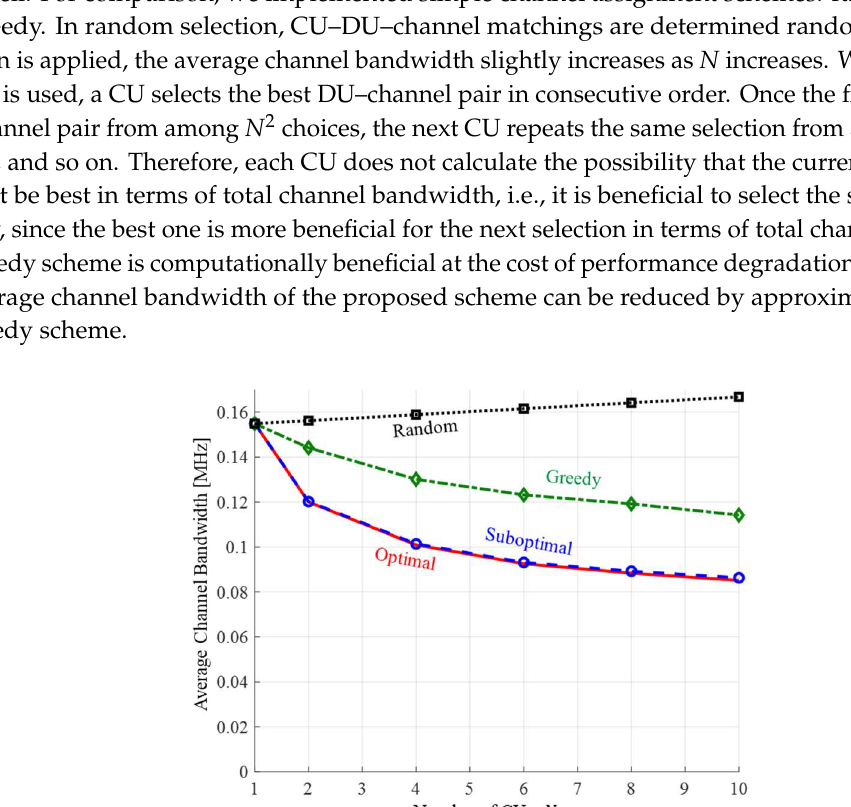
Figure 4. Snapshot of the iterative operation of the proposed channel assignment algorithm .